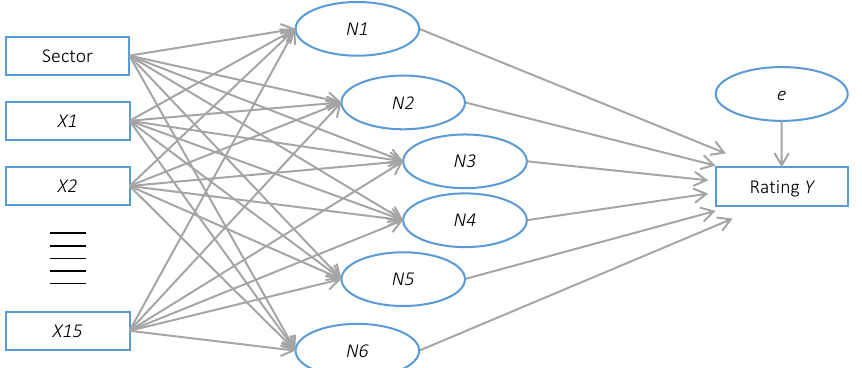
Figure 3. Network to estimate Moody’s ratings (Sample I)